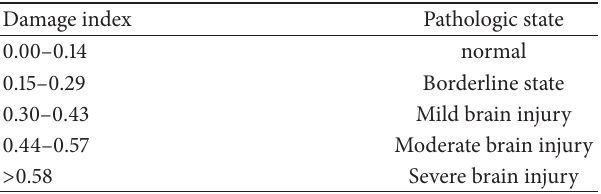
Table 1: HRB assessment